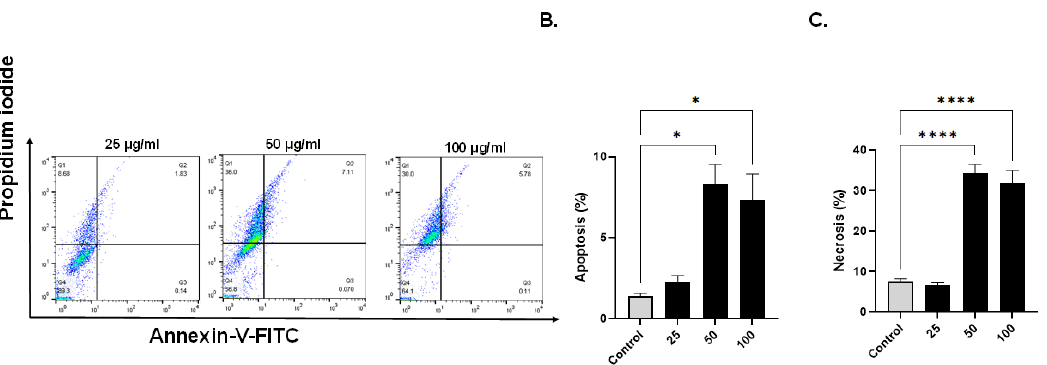
Figure 3. Evaluation of the apoptosis- and necrosis-inducing potential of ethanol extract of C. calcitrapa (EECC) in MDA-MB-231. ( A ): FACS analysis of by Annexin V-FITC/PI double staining of MDA-MB-231 cells after treatment with EECC at different concentrations for 48 h. EECC induced apoptotic and necrotic cell death in MDA-MB-231 cells. The Y-axis represents the PI-labeled population, whereas the X-axis represents the FITC-labeled annexin V positive cells. The four quadrants are representative of the following: Q1 quadrant (PI+/Annexin V − )—necrotic cells, Q2 quadrant (PI+/Annexin V+)—early apoptotic cells, Q3 quadrant (PI − /Annexin V+)—late apoptotic cells, Q4 quadrant (PI − /Annexin V − )—viable cells. ( B , C ): Cell population analysis (%) according to early apoptotic, late apoptotic and necrotic MDA-MB-231 cells treated after exposure to EECC (25, 50 and 100 µ g/mL), relative to non-treated control cells at different concentrations. * p < 0.05, **** = p < 0.0001 vs. control. Data represent mean ± SD of